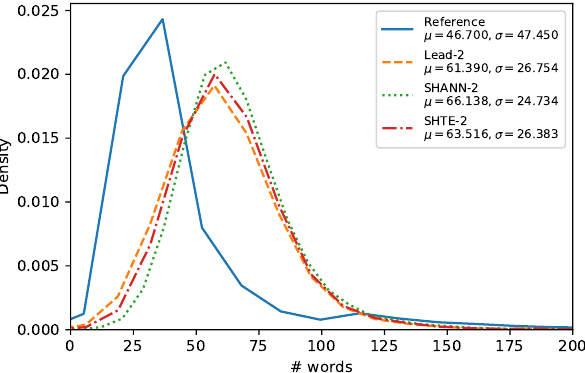
Figure 5. Word-length distribution of system generated summaries with k = 2 in comparison to human reference summaries for NR-Ext.